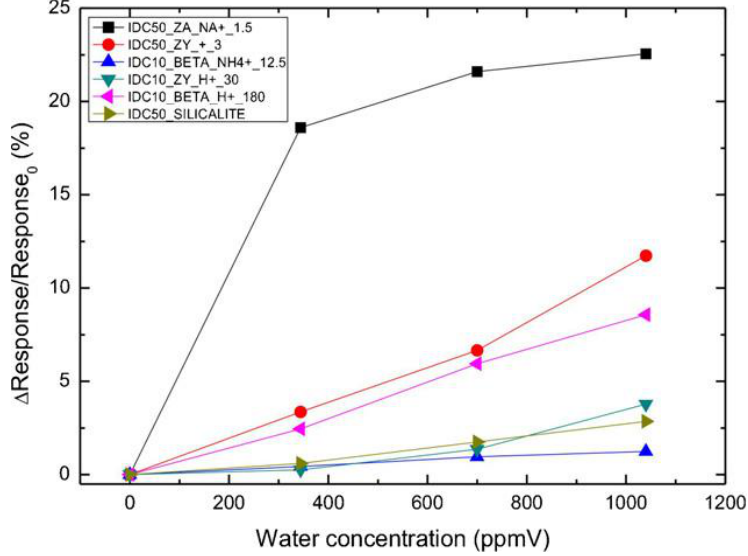
Figure 16. The performance of humidity sensors based on capacitance measurement of various zeolites coated on interdigitated electrodes at room temperature (adapted from Reference [65]).